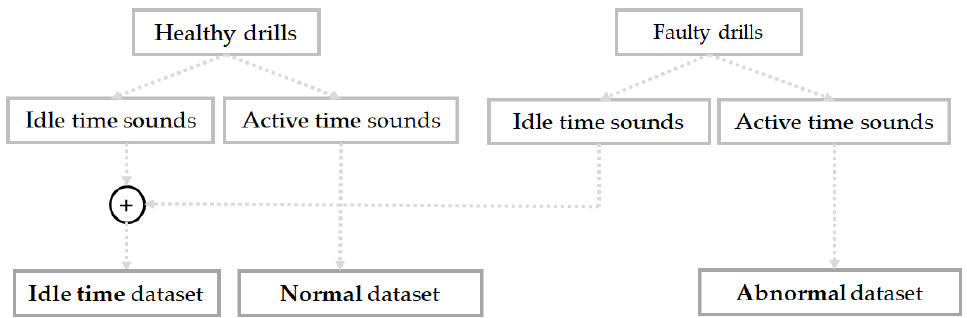
Figure 3. Representation of the datasets considered in this work: the idle time dataset comprises the sounds from both healthy and faulty drills during the idling stage.